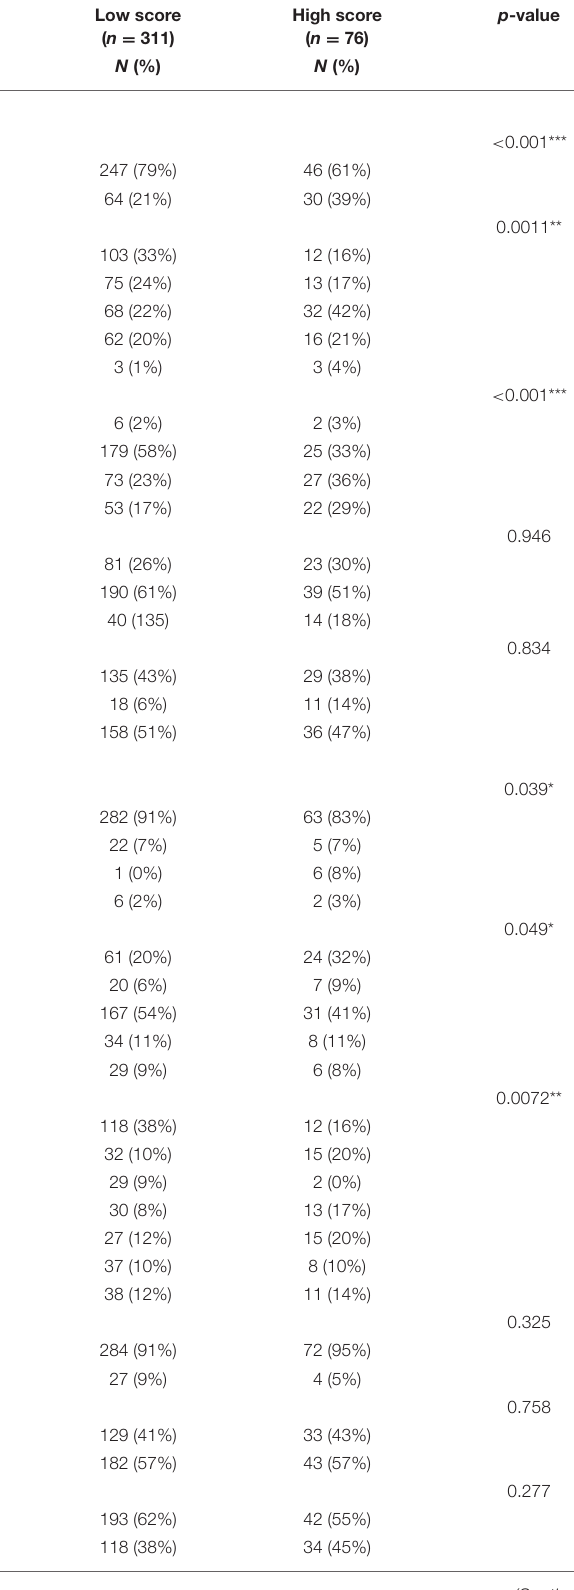
TABLE 3 | Baseline characteristics of nurses between low and high Berlin scores (low vs. high OSA risk groups). Items Low score Anamnesis